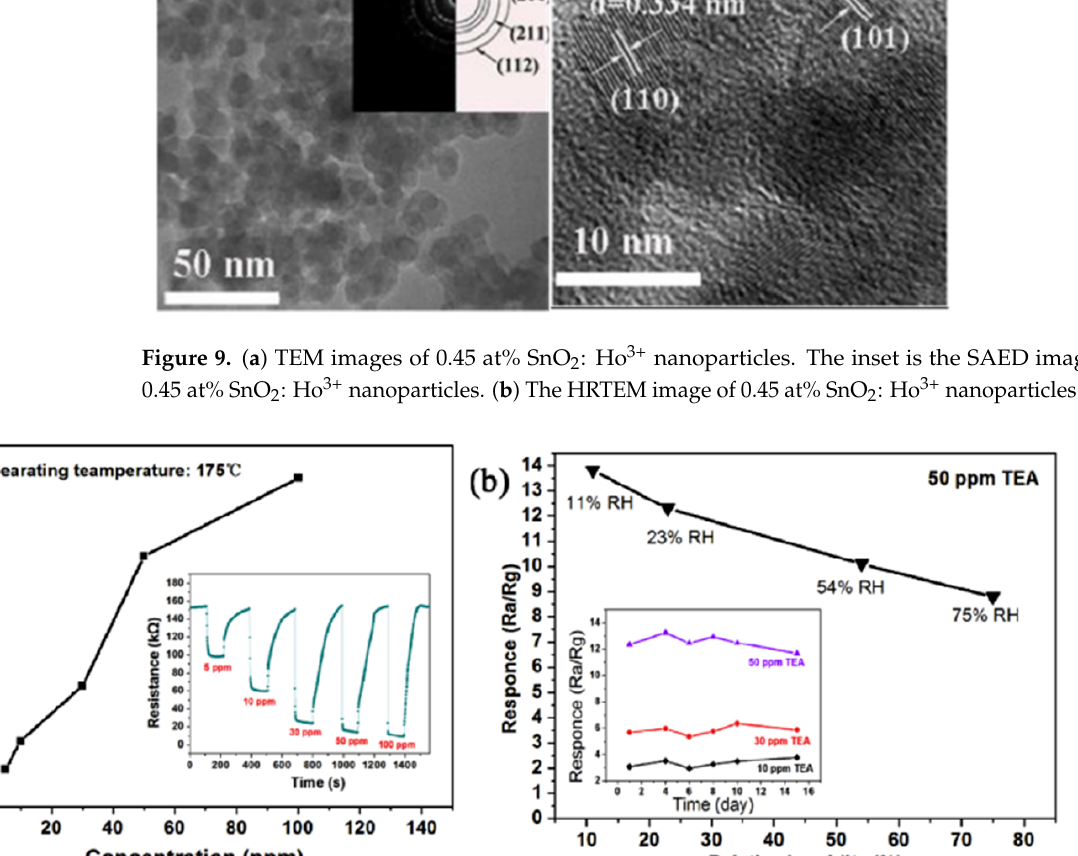
Figure 10. ( a ) A line chart of the relationship between the sensor response and the TEA concentration; ( b ) nanoparticle-based sensor responses to 50 ppm TEA under different RHs [88].